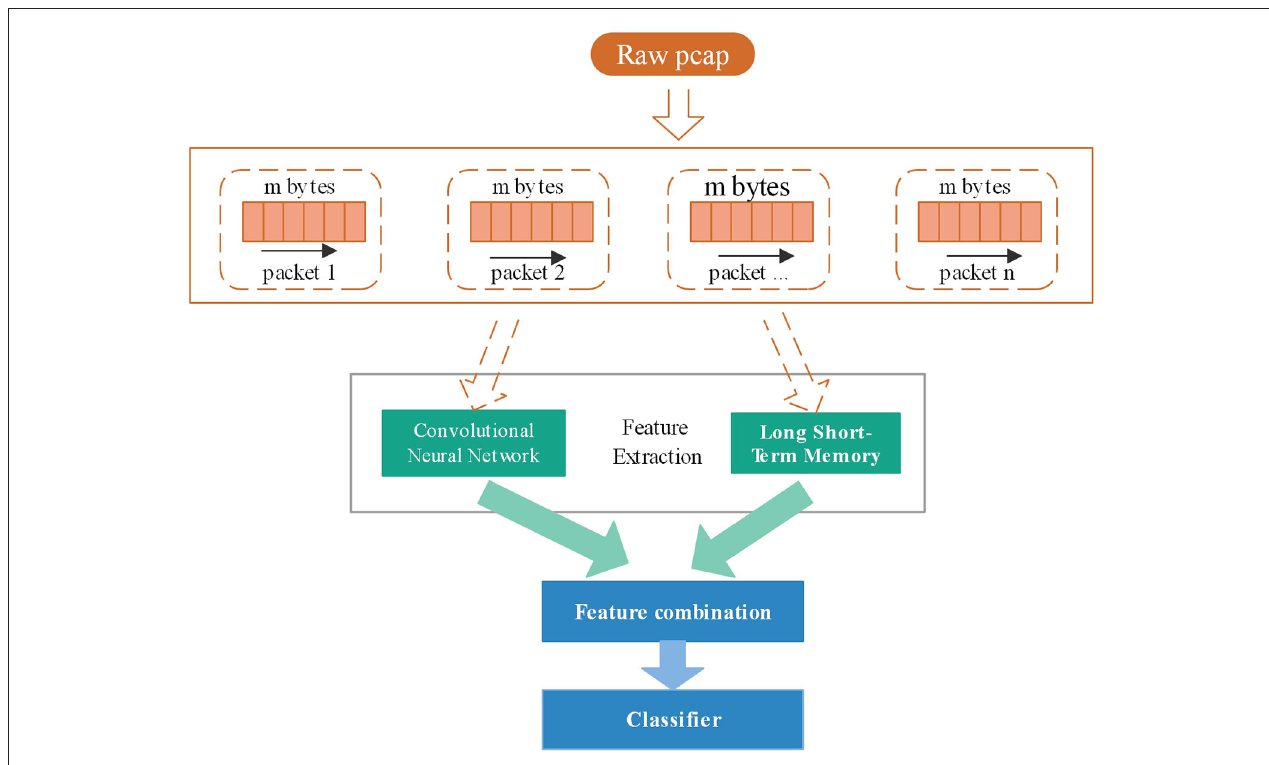
FIGURE 4 | Convolutional neural network and LSTM neural network joint processing model.